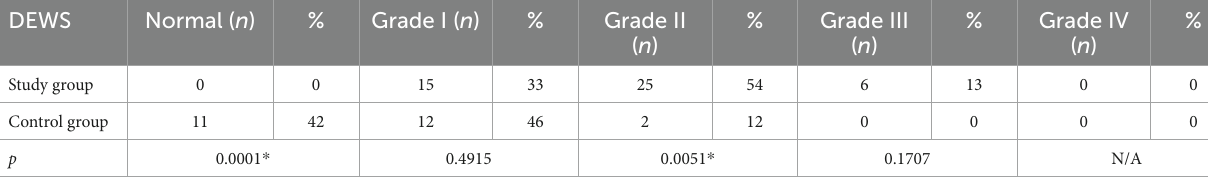
TABLE 4 DEWS grades distribution among study and control groups.